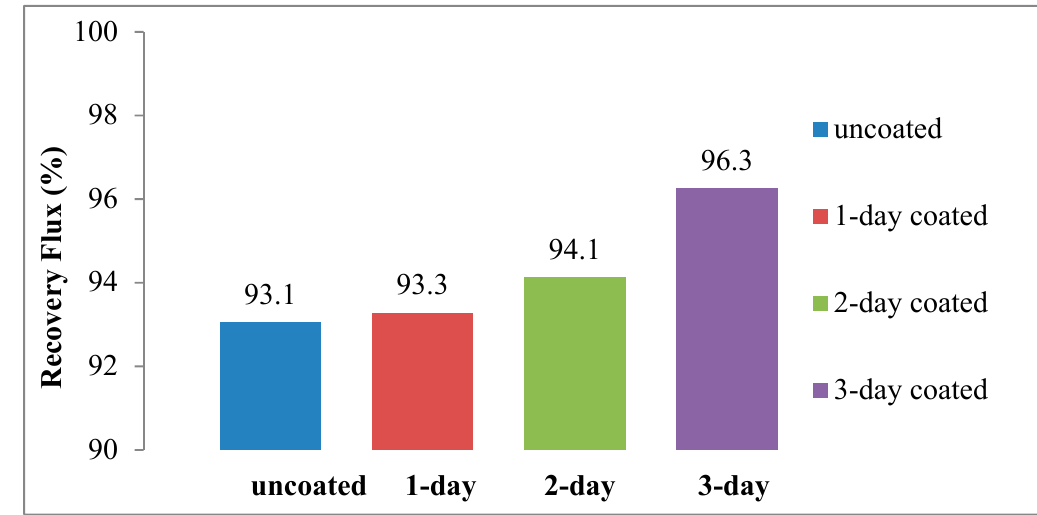
Figure 10. Recovery of the water flux for the UF membranes after cleaning.